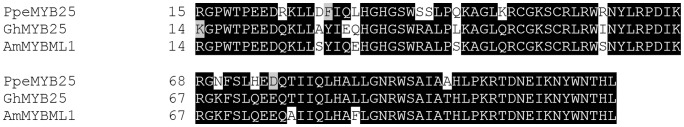
Aminoacid alignment of the R2 and R3 MYB repeat sequences.MYB domains (pfam00249) of peach PpeMYB25, cotton GhMYB25 (ACJ07153.1, [39]) and Antirrhinum AmMYBML1 (CAB433991.1, [54]) were aligned using the Muscle on line tool at EBI (http://www.ebi.ac.uk/Tools/msa/muscle/). Graphic display of the alignment was obtained using BoxShade (http://www.ch.embnet.org/software/BOX_form.html). Black shaded residues are identical, grey shaded residues are similar. Coordinates in the protein sequences are indicated.